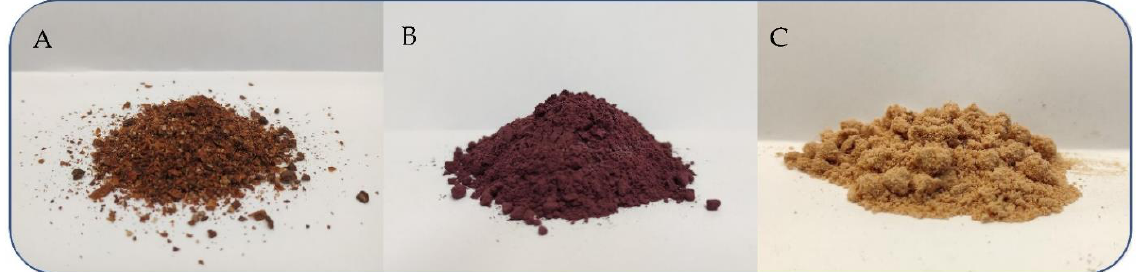
Figure 1. Feed additives supplemented in broiler diets: ( A ) ground grape pomace (GGP), ( B ) dried wine lees extract (rich in yeast cell walls; WYC), and ( C ) extract from grape stems included in soluble starch (PE).